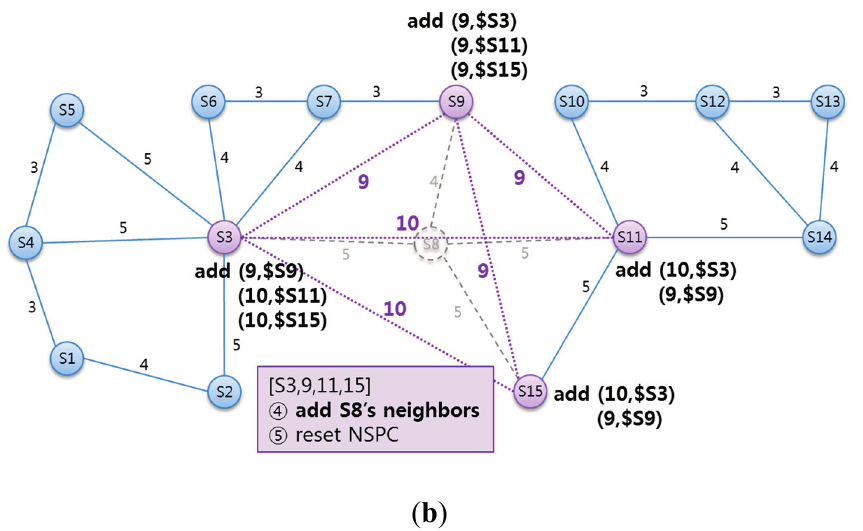
Figure 14. ( a ) Checking for a deleted SLiM Hub by heartbeat message; ( b ) Creating new paths to existent physical SLiM Hubs, notwithstanding of deleted SLiM Hubs.